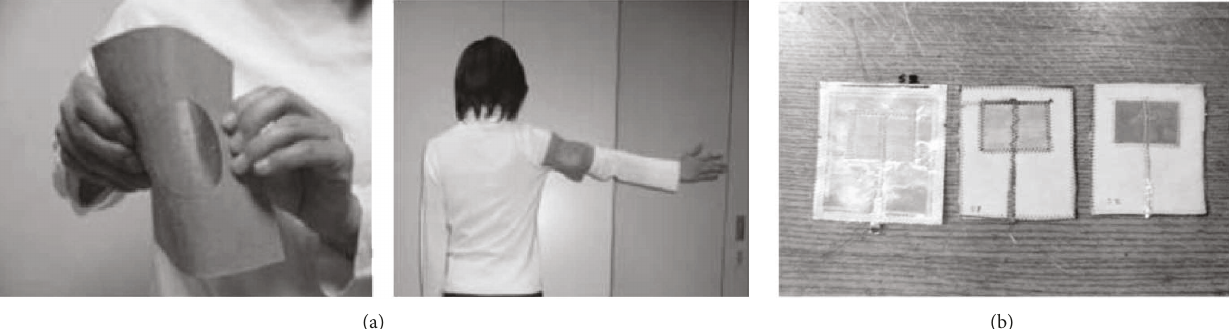
Figure 8: (a) Wearability of the antenna [53]. (b) Fabricated textile patch antennas. From left to right: applying copper tape, woven copper thread, and conductive spray [54].